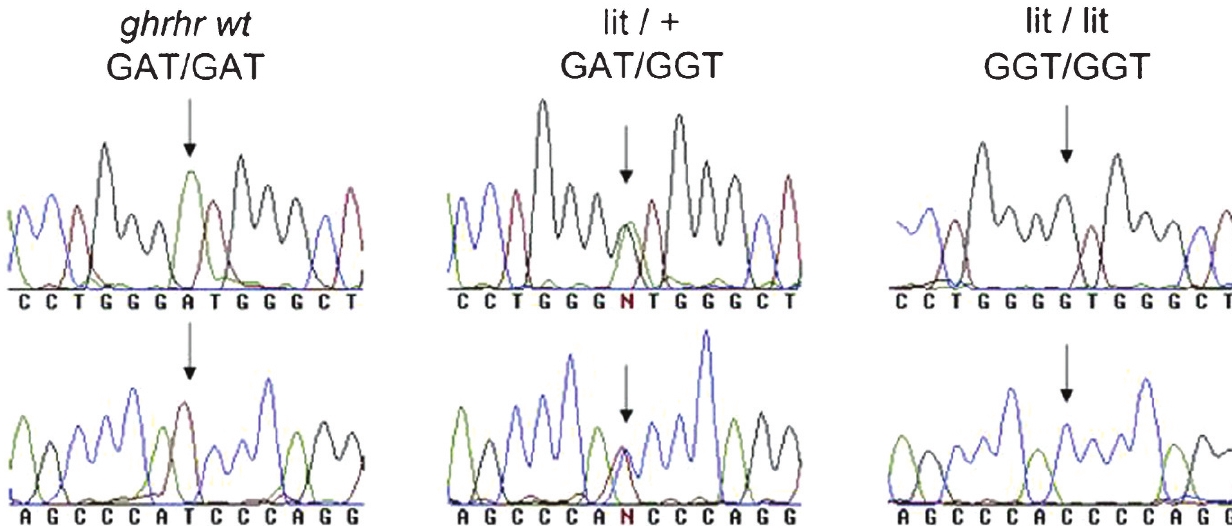
Figure 1 - The germline ghrh-r Asp60Gly mutation analysis was performed by PCR amplification and direct automated sequencing. The chromatogram traces show the GAT/GAT (wild-type), GAT/GGT (heterozygous mouse) and GGT/GGT (little mouse) statuses, thus characterizing the genotype of the three mice strains used in this study. The forward and reverse traces are shown in the top and bottom panels, respectively.